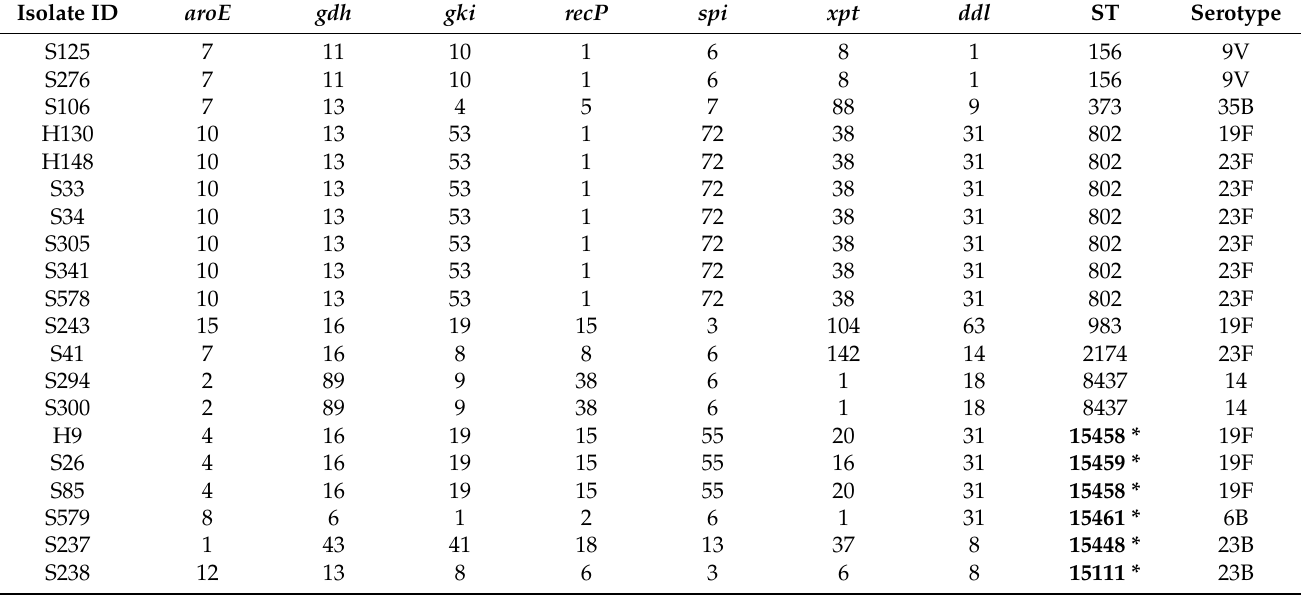
Table 2. MLST of 20 selected multidrug ‐ resistant pneumococci isolates.